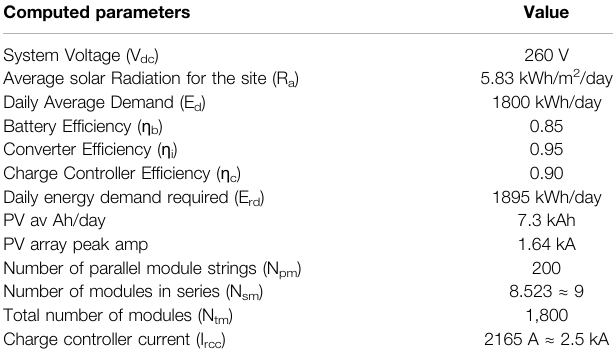
TABLE 1 | Computed PV module parameters. Computed parameters